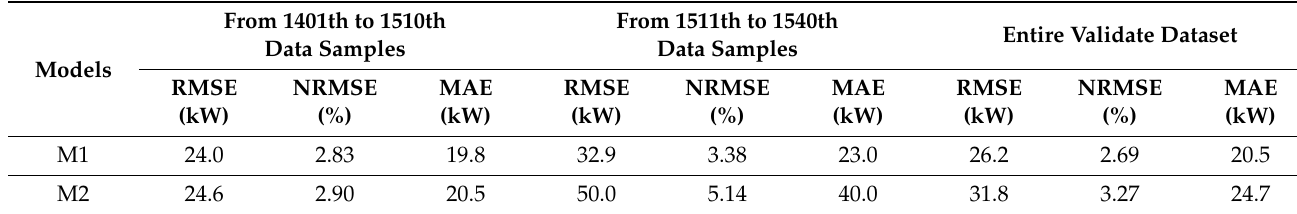
Table 2. Estimation errors of the motor power in validation dataset.